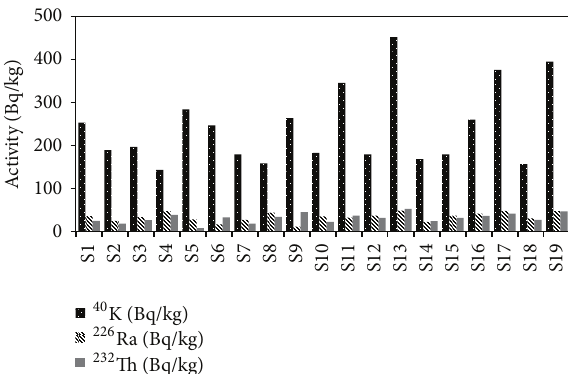
Figure 3: The activity concentration of 40 K, 226 Ra, and 232 Th for all samples.